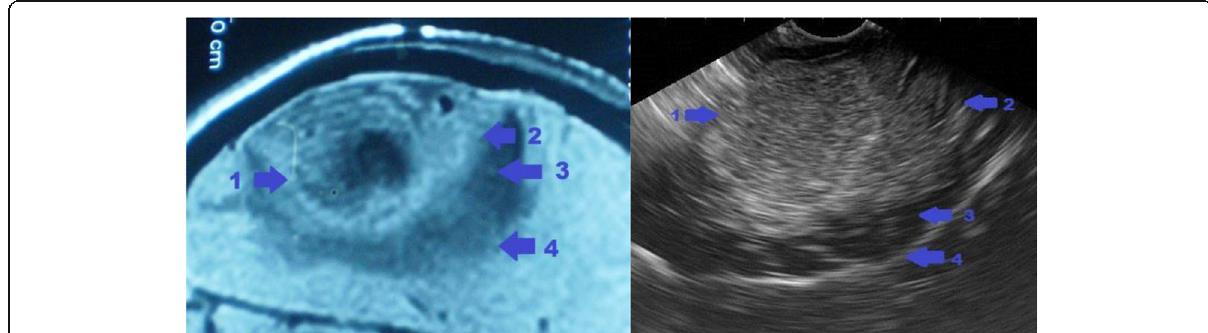
Fig. 2 Brain edema; arrow1 brain mass lesion, arrow2 heterogeneous hyper-echogenic brain edema, arrow3 hypo-echogenic brain edema, and arrow4 interface between brain and edema